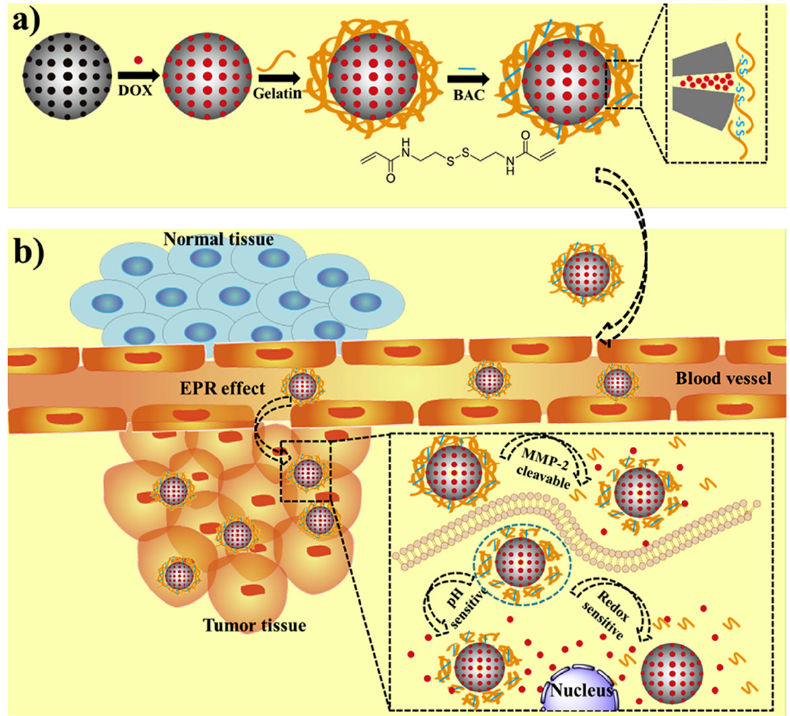
Figure 2. ( a ) Schematic representation of the synthesis of the enzyme- and redox-responsive MSNs. ( b ) Schematic representation of the mechanism of action. The overexpressed metalloproteinases can partially degrade the gelatin coating, which can be completely degraded due to the action of GSH. Reproduced with permission from [20]. Copyright Elsevier, 2019.